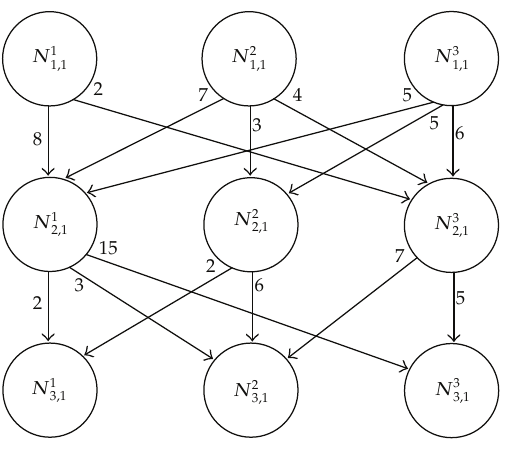
Figure 2: An example network in